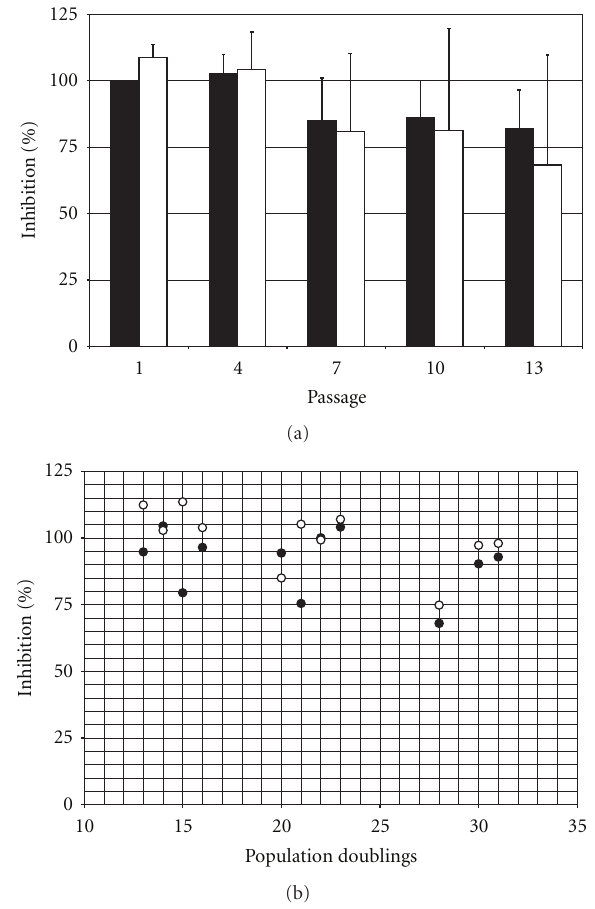
Figure 6: E ff ect of culture conditions on the immunosuppressive activity of hMSCs. Immunosuppressive activity of medium condi- tioned by IL-1 β -stimulated hMSCs expanded in control or FGF- supplemented medium. Values are normalized to the inhibitory activity of first passage hMSCs expanded in control conditions. (a) Immunosuppressive activity (mean ± standard deviation; n = 5) of medium conditioned by IL-1 β -stimulated hMSCs from di ff erent passages expanded in control (black bars) or FGF-supplemented (white bars) medium. (b) Immunosuppressive activity of medium conditioned by IL-1 β -stimulated hMSCs expanded in control (black circles) or FGF-supplemented (white circles) medium. The data are presented as pairs of preparation- and passage-matched hMSCs subsets. Note that for 8 of the 11 data pairs (73%) the conditioned medium from FGF-treated hMSCs is more immuno- suppressive than that of their control counterparts. Overall, the di ff erences in immunosuppressive activity between conditioned media from control and FGF-treated cells are significant (one-tail paired t -test; P = .